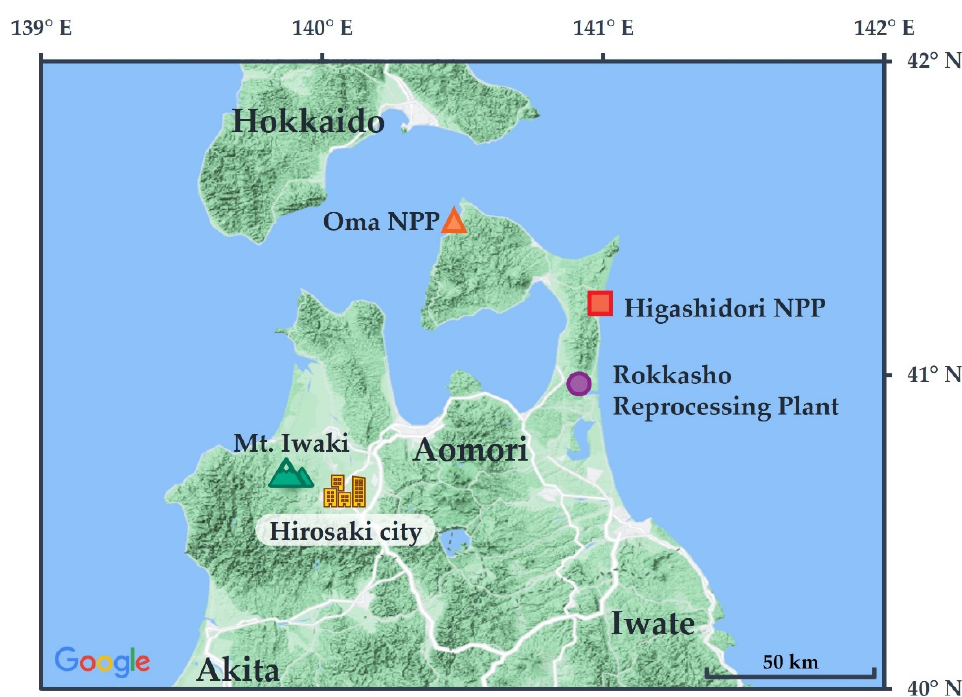
Figure 1. Map of Aomori Prefecture and locations of Hirosaki City, nuclear facilities, and Mt.